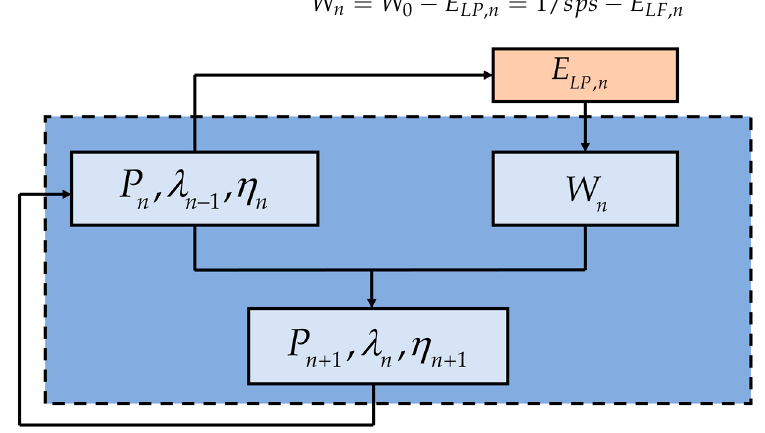
Figure 7. The flowchart of NCO in Figure 7. The fl owchart of NCO in CB-Gardner.